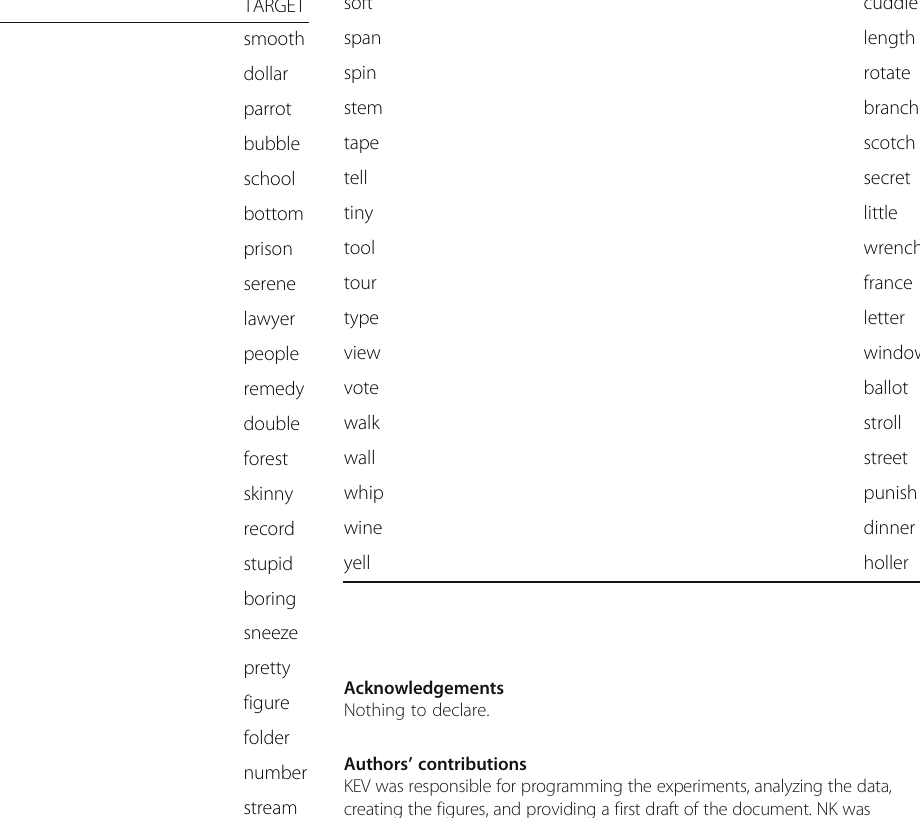
Table 3 Cue-target pairs used in Experiment 4